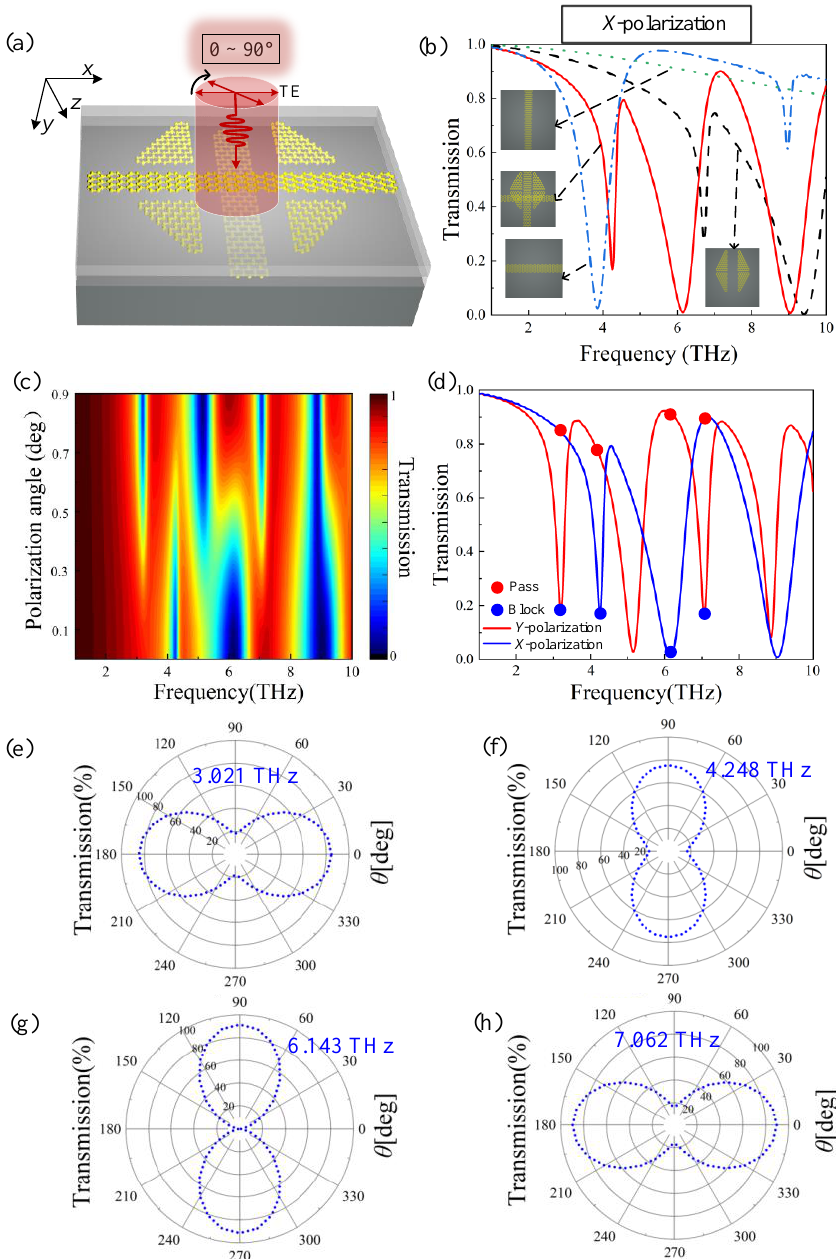
Figure 5. ( a ) Schematic diagram of the structure of the light polarization angle varying from 0° to 90°. ( b ) Transmission spectra of different structures under x -polarization. ( c ) Evolution of the transmission spectra with varying angles of polarization. ( d ) Transmission spectra of x -polarization and y -polarization. ( e – h ) Transmittance function with polarization angle as a variable.